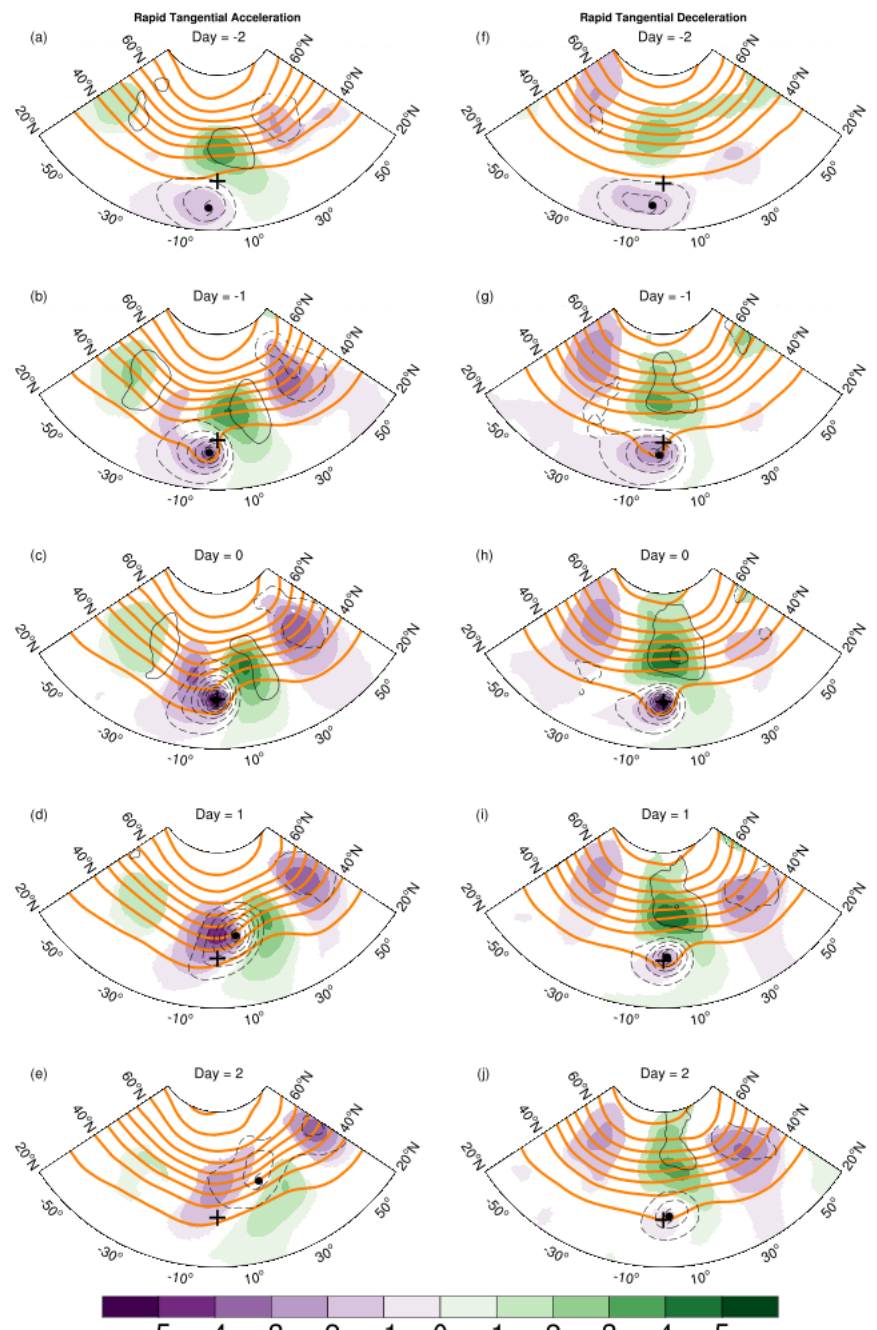
Figure 4. Storm-relative average 500hPa geopotential heights (thick orange lines) and anomalies (color shaded) for all TCs located in the latitude bin 30–40 ◦ N over the Atlantic. The fields are shown for lags Day − 2 to Day + 2. In each panel, the composite 1000hPa anomalous geopotential is shown using thin black contours. All anomalies are defined relative to a long-term synoptic climatology. The contour interval is 6dam, and the shading interval in decameters is shown in the label bar. The plus symbol shows the location of the composite TC at Day 0, and the hurricane symbol shows the approximate location at each lags. Panels (a) – (e) show rapid tangential acceleration, and panels (f) – (j) show rapid tangential